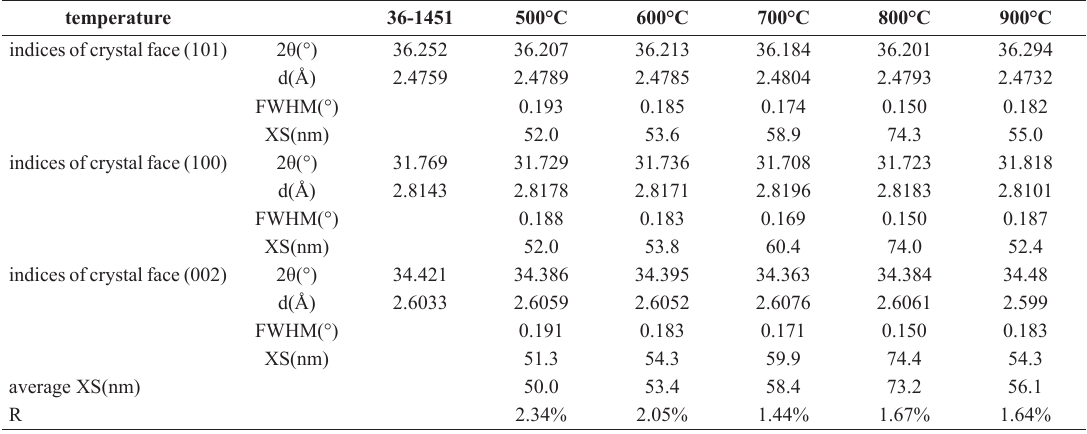
Table 1. XRD diffraction profile data from the ZnO powders prepared at different thermal oxidation temperatures. temperature